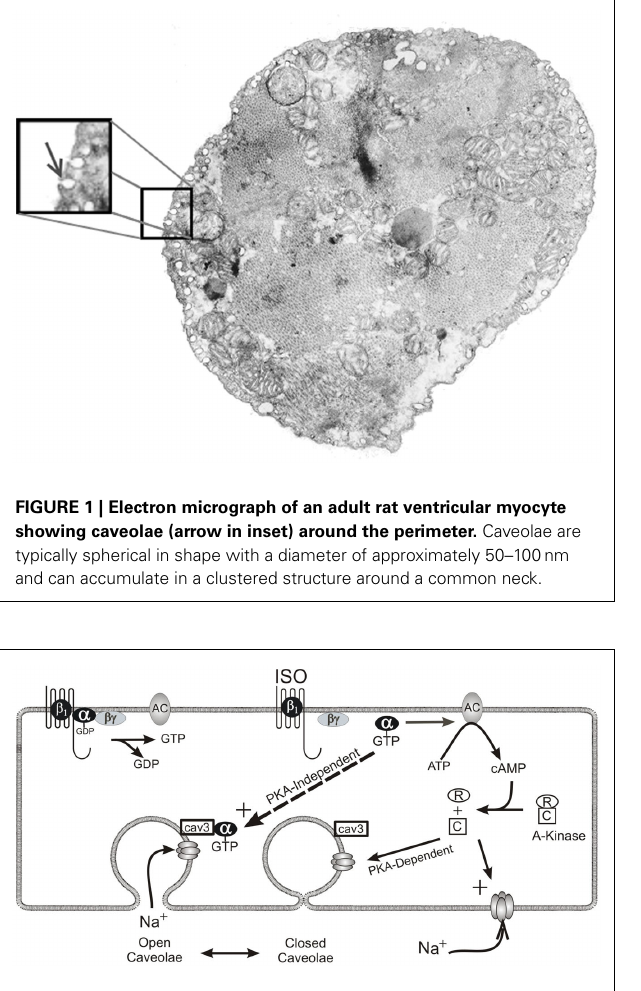
FIGURE 2 | β -Adrenergic modulation of cardiac sodium current via two pathways. One pathway enlists PKA’s catalytic subunit to increase phosphorylation at the sodium channel thereby changing the kinetics of the channel itself.The second pathway involves a direct interaction between the α -subunit of the stimulatory G-protein and caveolin-3.This interaction results in the presentation of additional functioning sodium channels to the sarcolemma. It is important to note that this direct mechanism does not involve changes to ion channel